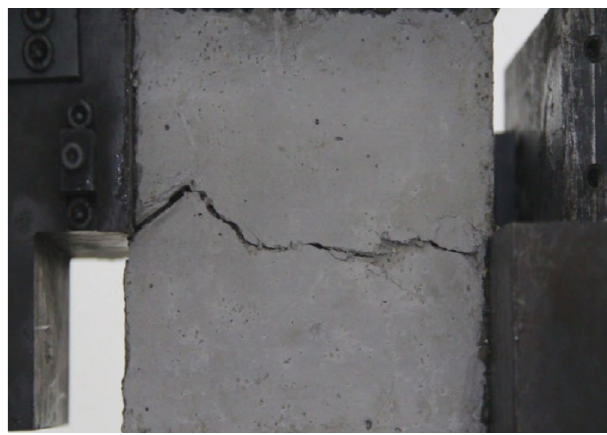
Figure 14. Photograph of a specimen showing fractures penetration.